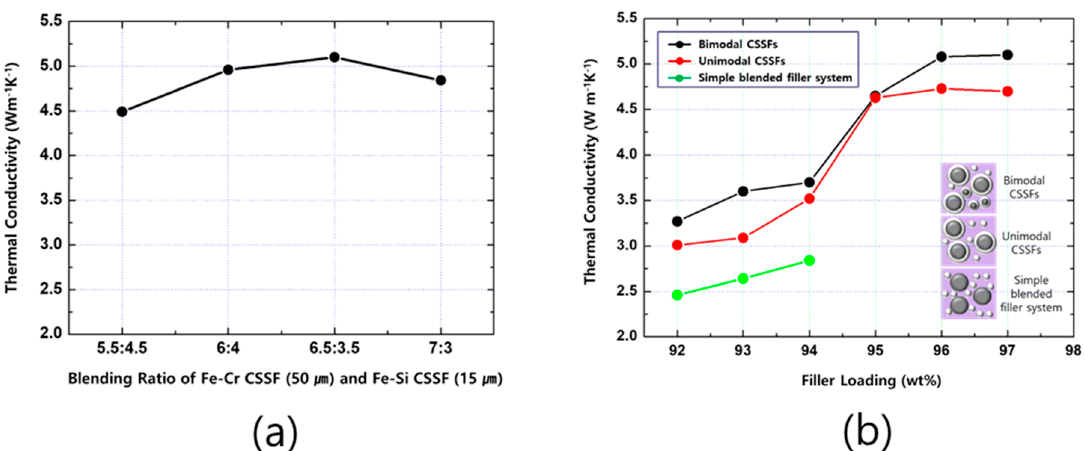
Figure 8. ( a ) Thermal conductivities (TCs) of dual-functional sheets with a blending ratio of larger to smaller sized CSSFs and the ( b ) comparison of the TCs of DFSs made of bimodal CSSFs, unimodal CSSFs, and simple blended filler systems.